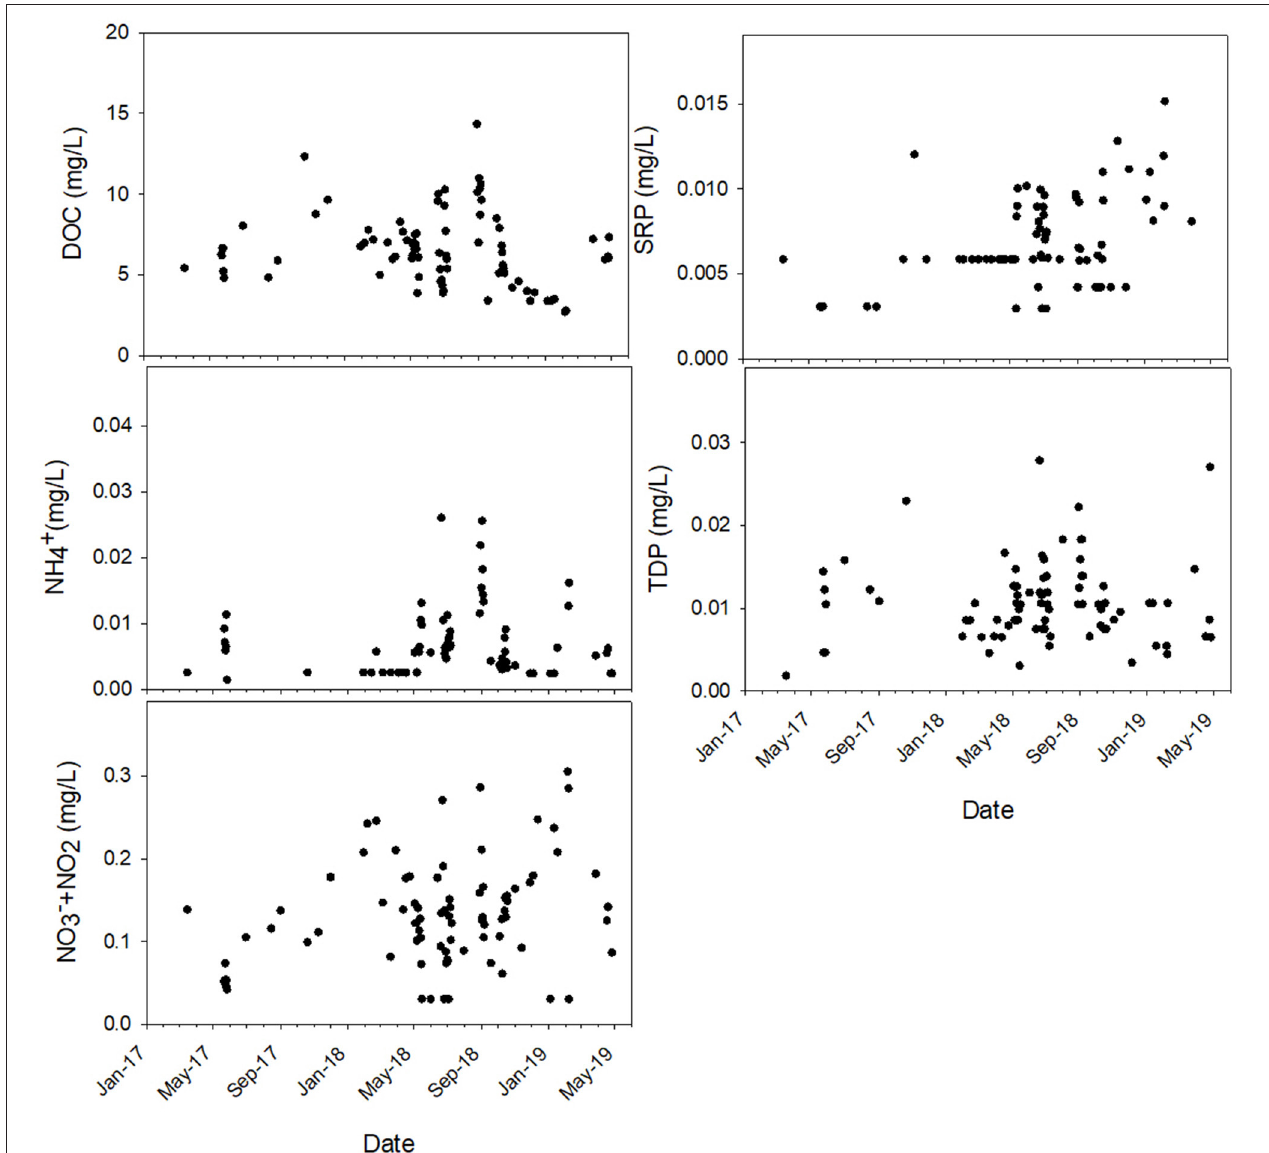
FIGURE 4 | Nutrient concentrations during each sampling throughout the sampling period. Y -axis range for each plot matches the range of the data to demonstrate variation across the study